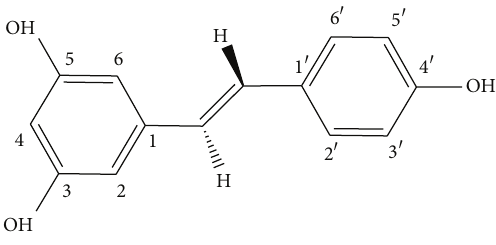
Figure 1: Molecular structure of